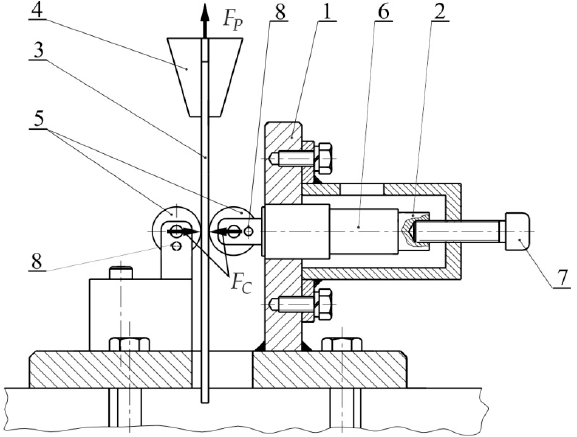
Figure 3. Principles of strip drawing test 1—base, 2—teflon insert, 3—specimen, 4—upper grip of testing machine, 5—cylindrical rolls, 6—mandrel, 7—set screw, 8—fixing pin, F p —friction force, F c —clamping force.